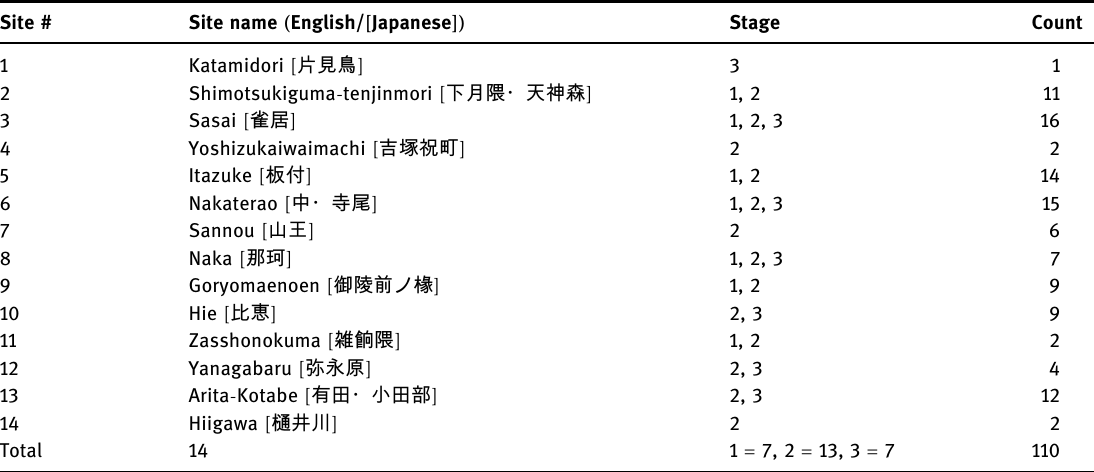
Table 1: List of site names, associated temporal stages, and vessel counts Site